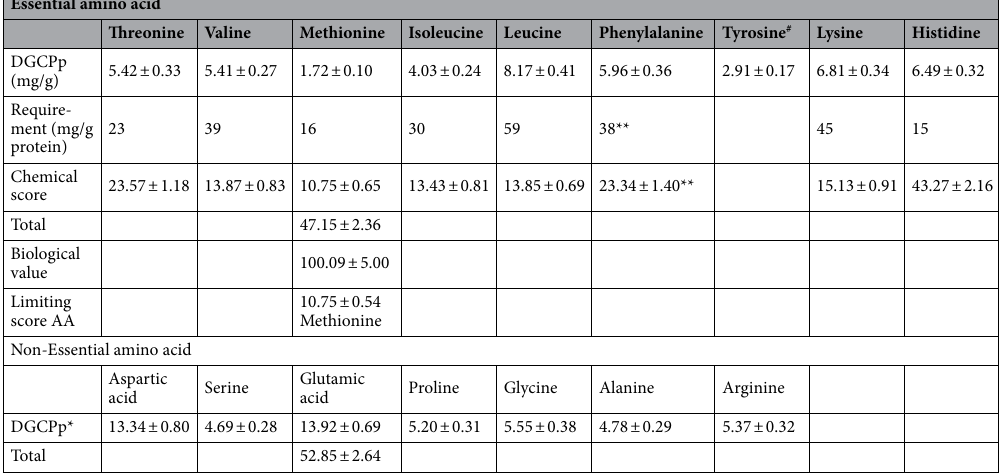
Essential amino